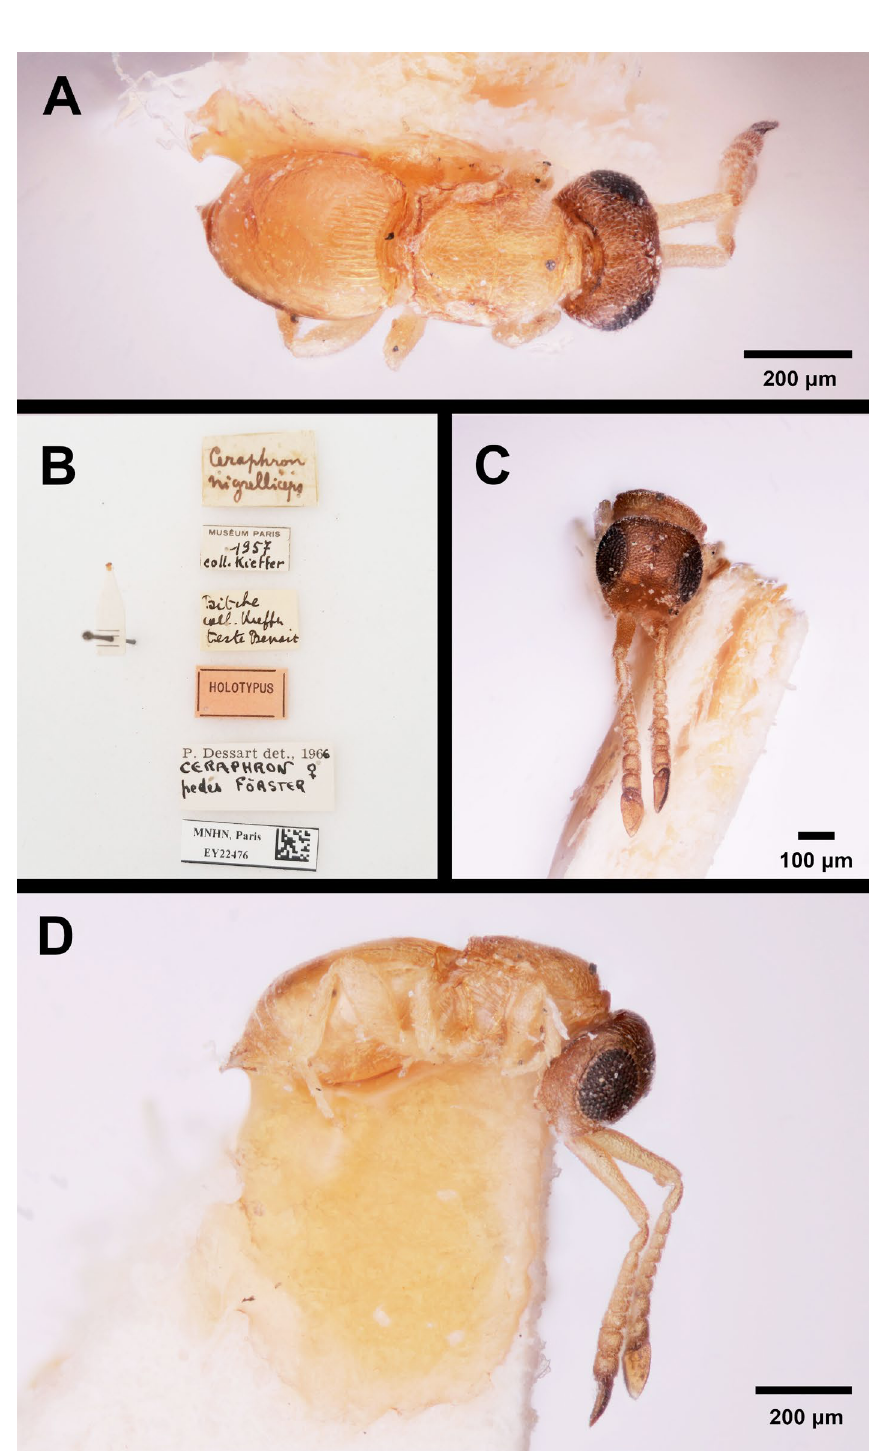
Fig. 14. Ceraphron nigrelliceps kieffer, 1907, syntype, ♀ (MNhN EY22476). A . Dorsal view. B . Labels. C . Frontal view. D . Lateral